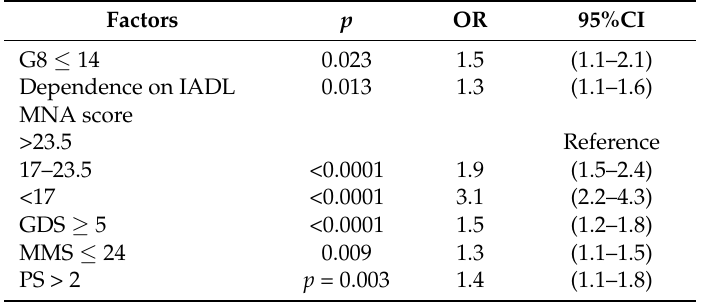
Table 5. Independent factors associated with an increased need of geriatric